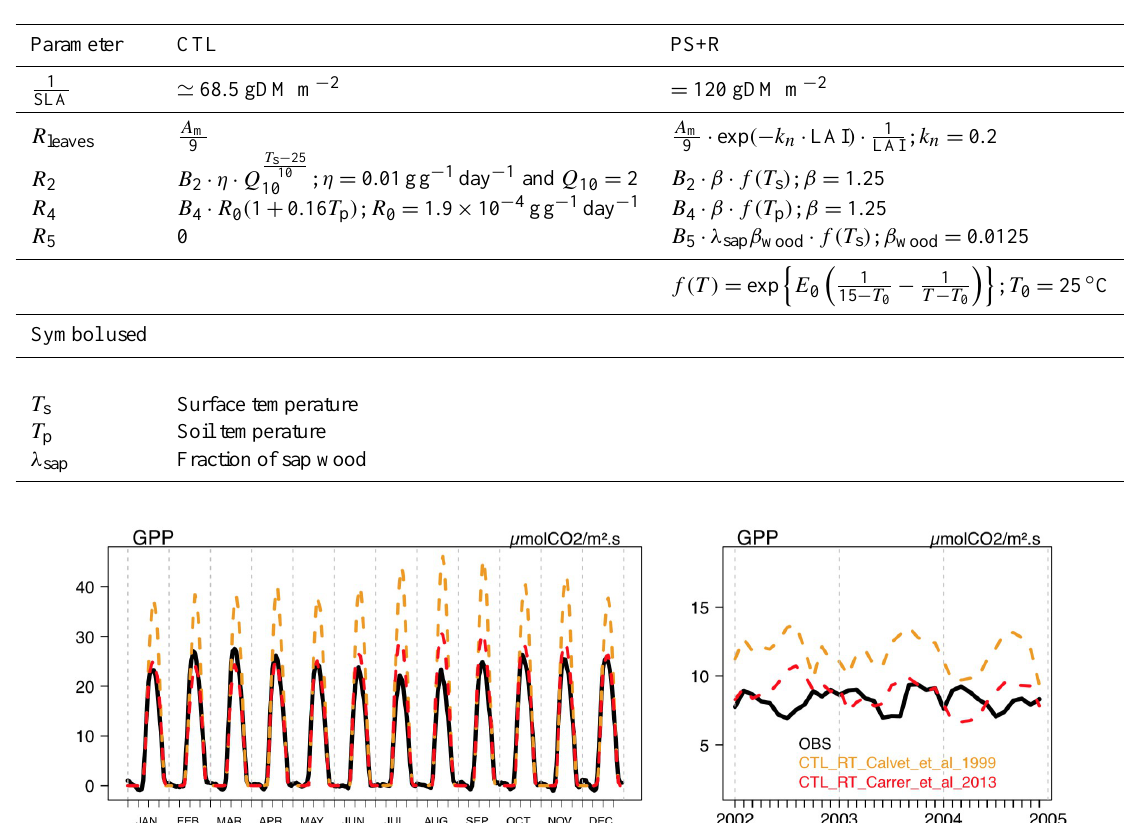
Table 4. ISBA CC : modifications autotrophic respiration ( R A ) functions PS+R version.